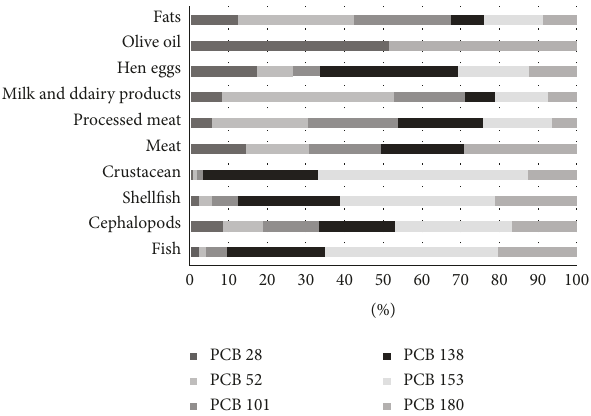
Figure 1: Percentage of contribution (%) from each congener to the sum of six